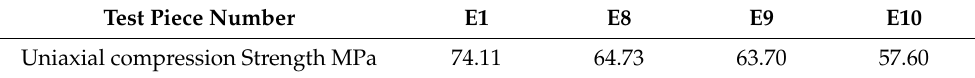
Table 4. Uniaxial compressive strength of limestone specimens with different water content rates.